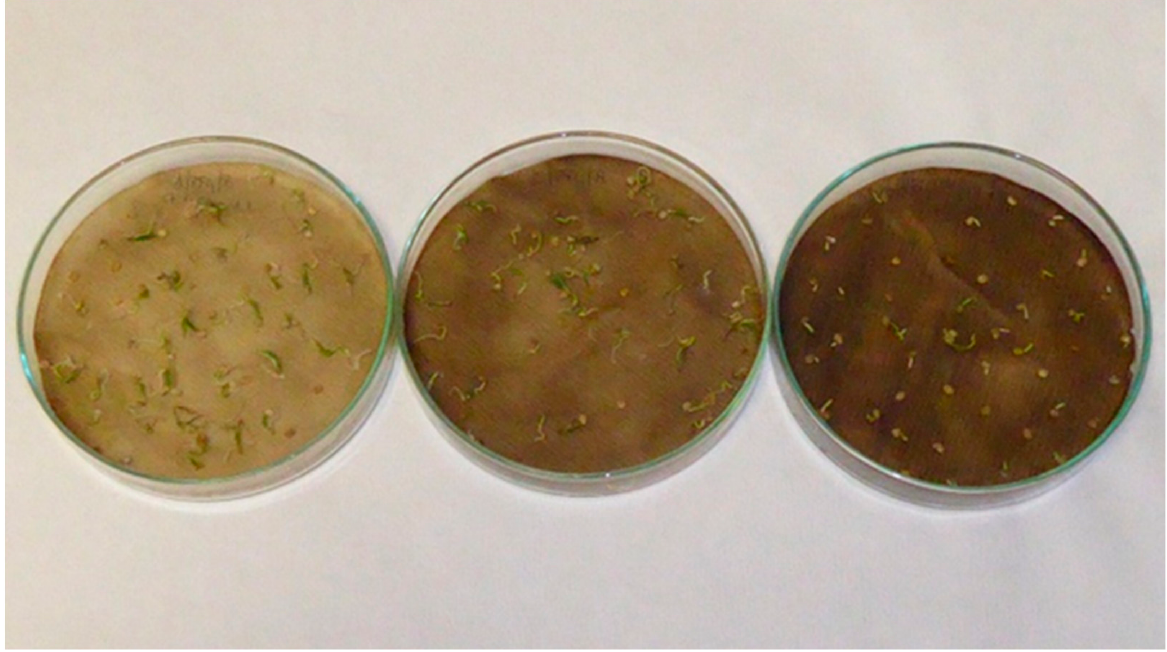
Figure A4. Pepper ( Capsicum anuum L.) seedlings; treatments with aqueous extracts of nettle ( Urtica dioica L.) in 2.5% concentration ( left ), 5% concentration ( middle ) and 10% concentration ( right ).